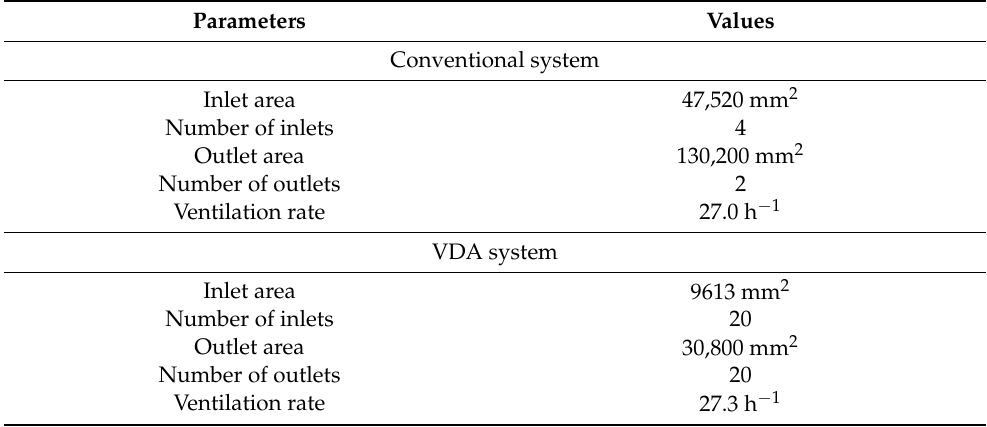
Table 3. Geometric parameters of the conventional and vertical drop airflow (VDA) systems.